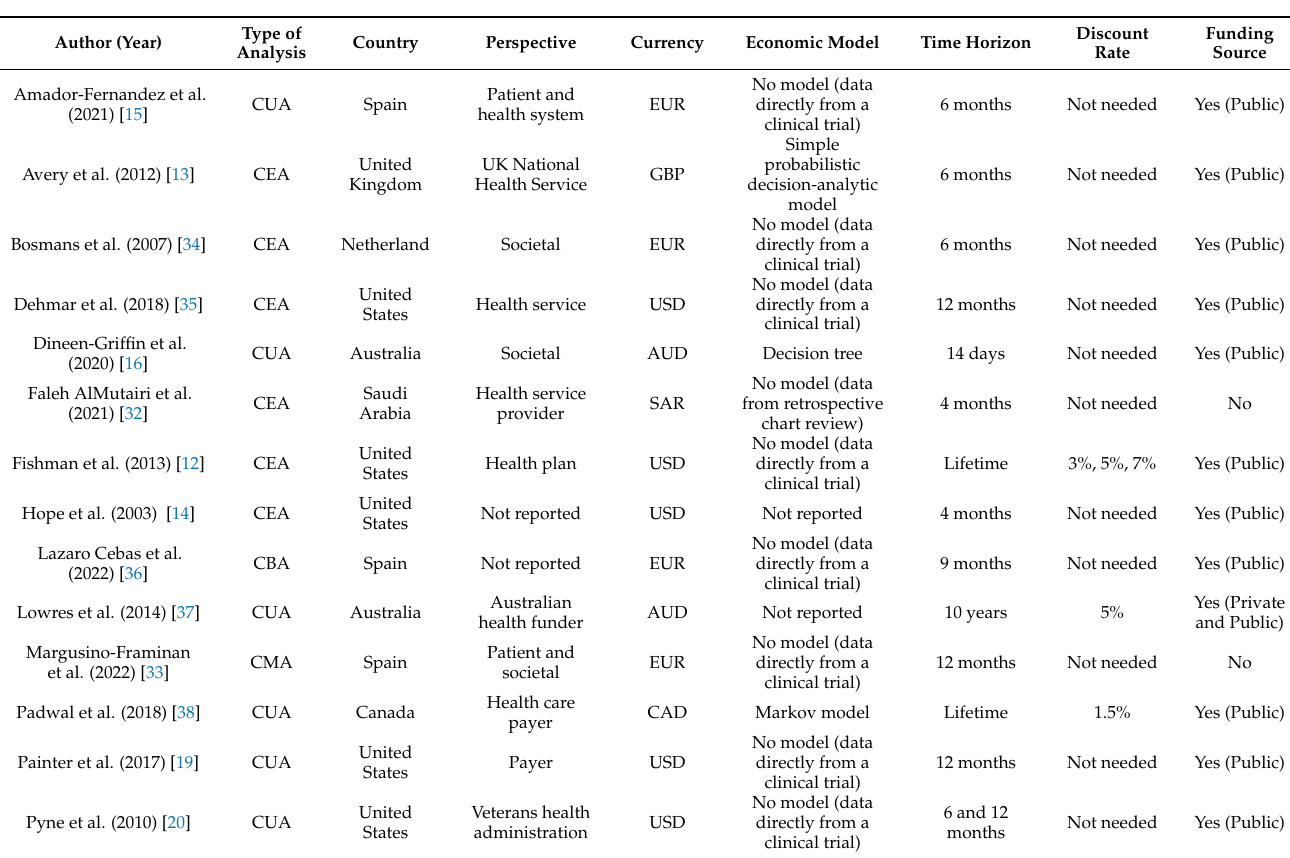
Table 2. Characteristics of the included economic